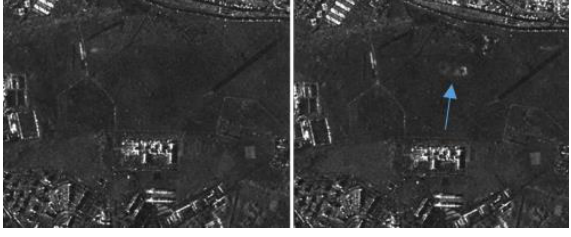
Figure 14. Feature extraction on SAR time-series